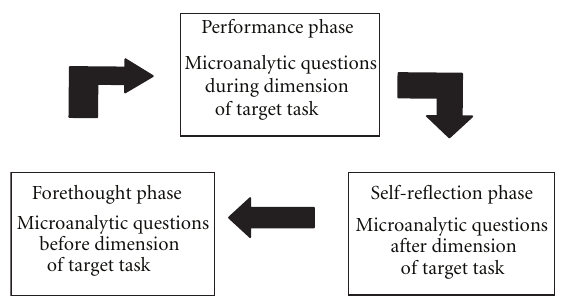
Figure 2: Temporal sequencing of questions administered as part of SRL microanalytic protocols. Forethought microanalytic questions are administered before task initiation, performance microanalytic questions are administered during the task, and reflection microanalytic questions are administered after the task is completed or a relevant performance outcome is